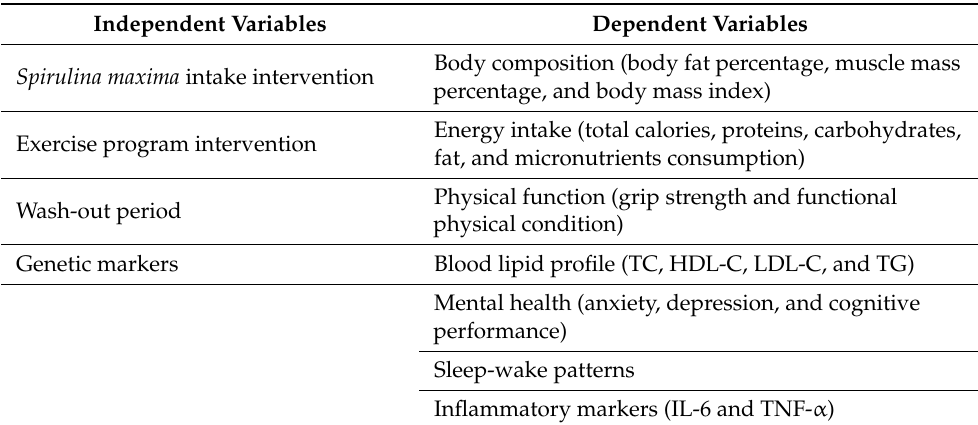
Table 2. Summary of the independent and dependent variables of the Spirulina maxima intake and exercise (SIE) randomized controlled